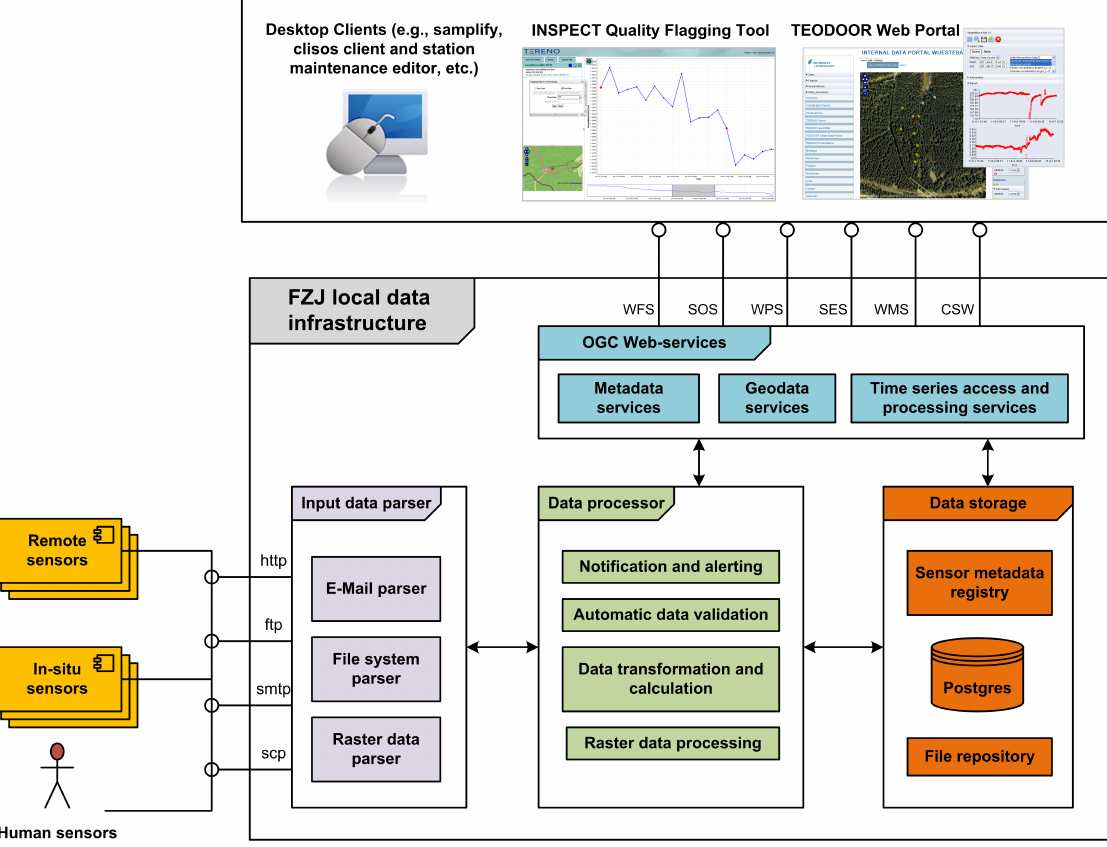
Figure 1. TEODOOR data